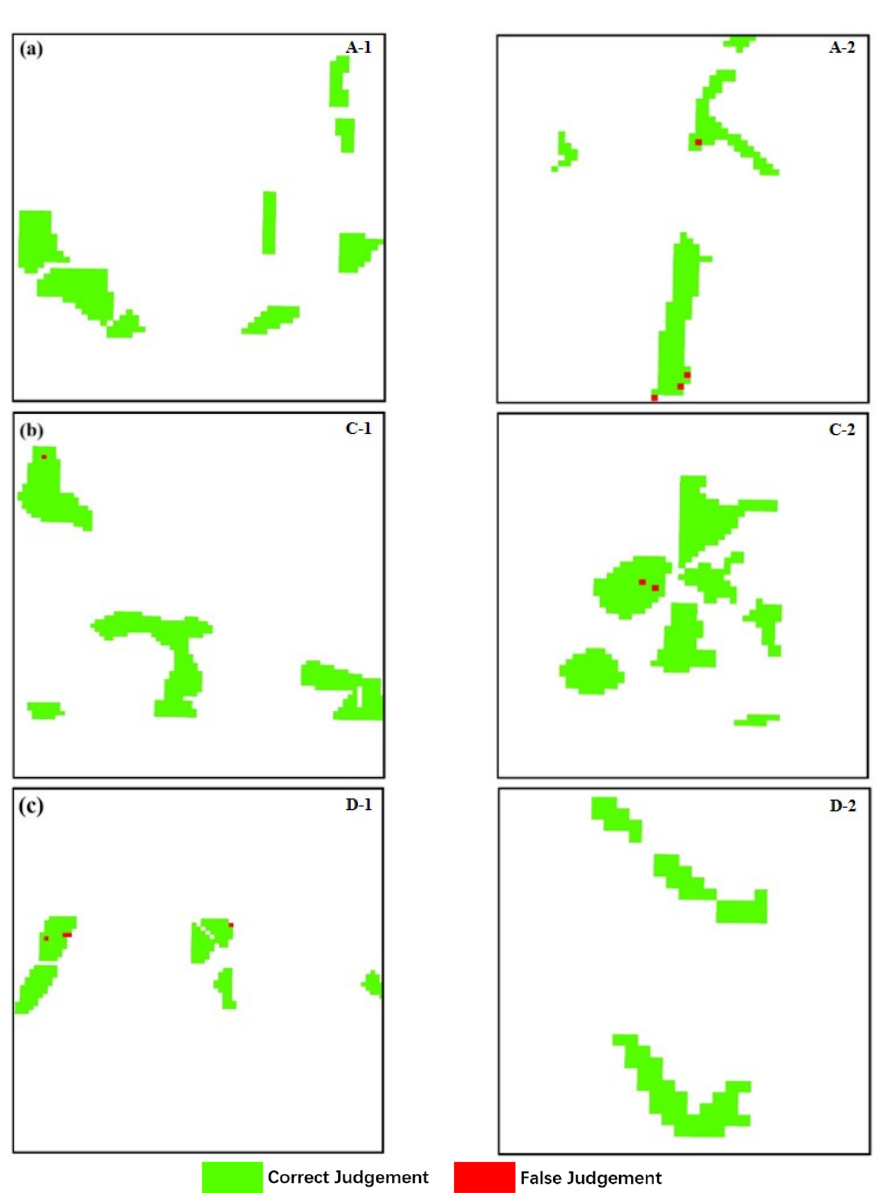
Figure 8. Classification results for ( a ) non-stress, ( b ) moderate stress, and ( c ) severe stress areas.